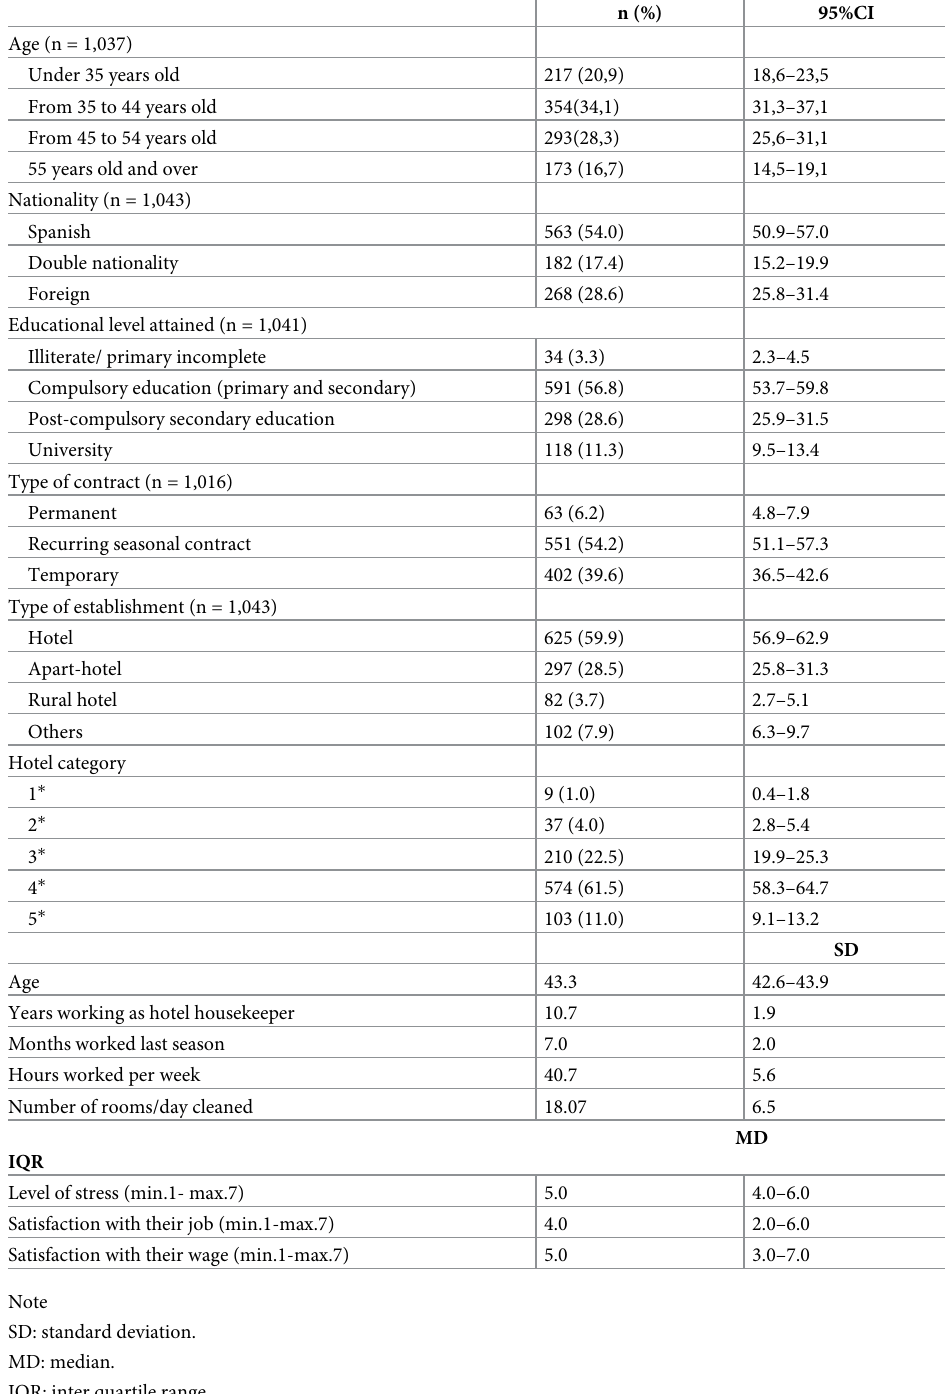
Table 1. Sociodemographic, individual and labour